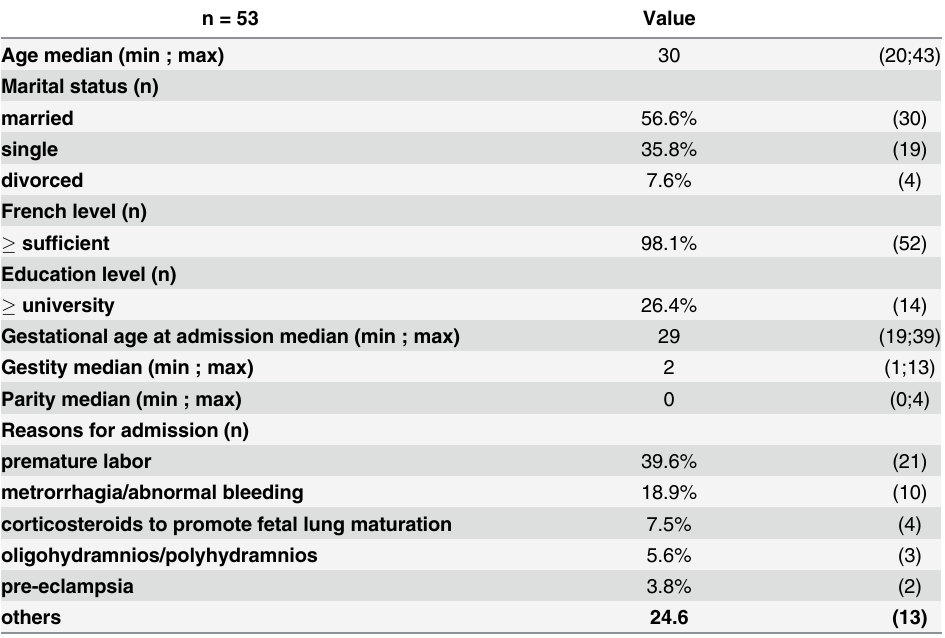
Table 1. Characteristics of